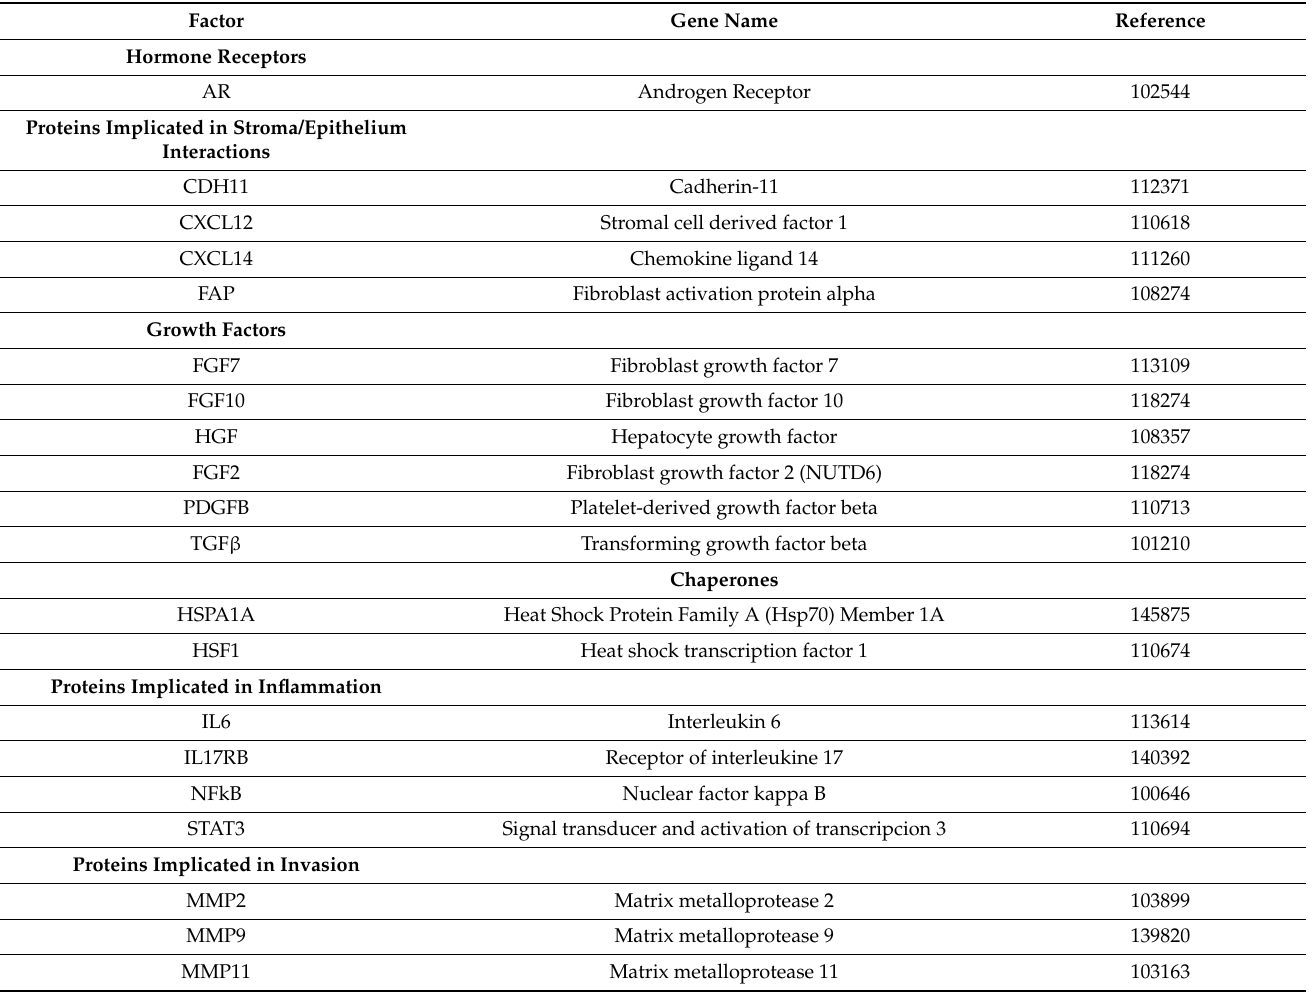
Table 2. Stromal factor analyzed in cultured fibroblasts from patients with prostate cancer and